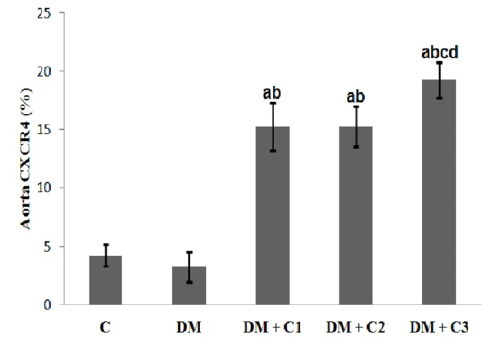
Figure 5. The aorta expression of CXCR4 in each experimental groups. Values are presented as mean ± SD; a P < 0.05 in comparison with control (C) group; b P < 0.05